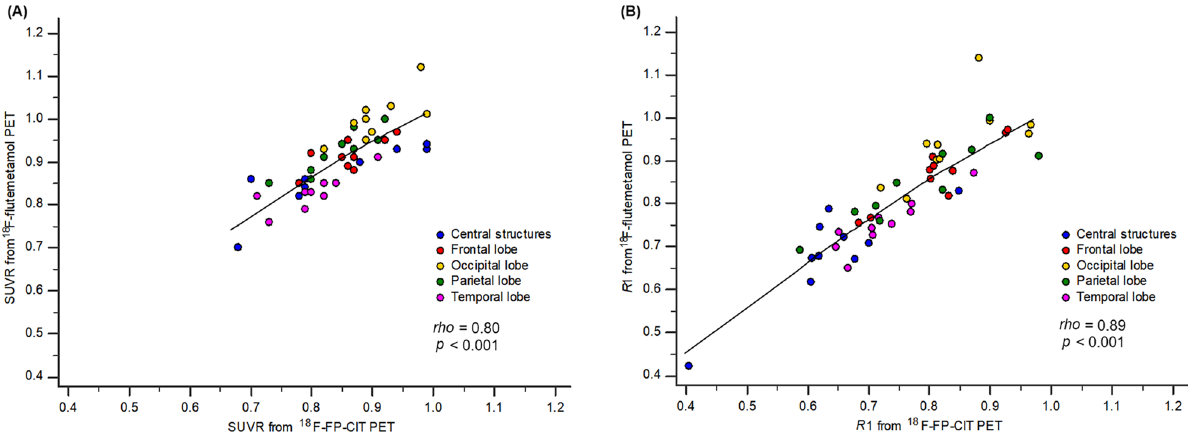
Figure 2. Scatter diagram of the correlation of parameters between 18 F-FP-CIT PET and 18 F-flutemetamol PET in the early phase. The early-phase SUVR obtained from 18 F-FP-CIT PET showed a very strong correlation with that from 18 F-flutemetamol PET in total brain regions including all cerebral lobes and central structures ( rho = 0.80, p < 0.001, A ). A very strong correlation of R 1 was also observed between the two PETs in total brain area ( rho = 0.89, p < 0.001, B ). The trend line is drawn with the local weighted regression smoothing span (100%) in each